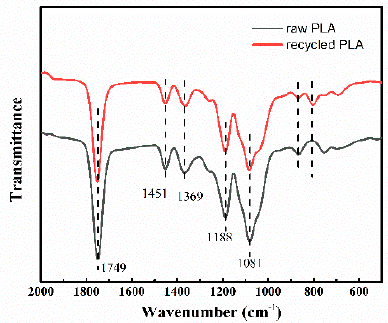
Figure 11. FTIR spectra of raw PLA and recycled PLA. Table 6. Molecular weight variation in PLA before and after recycling.